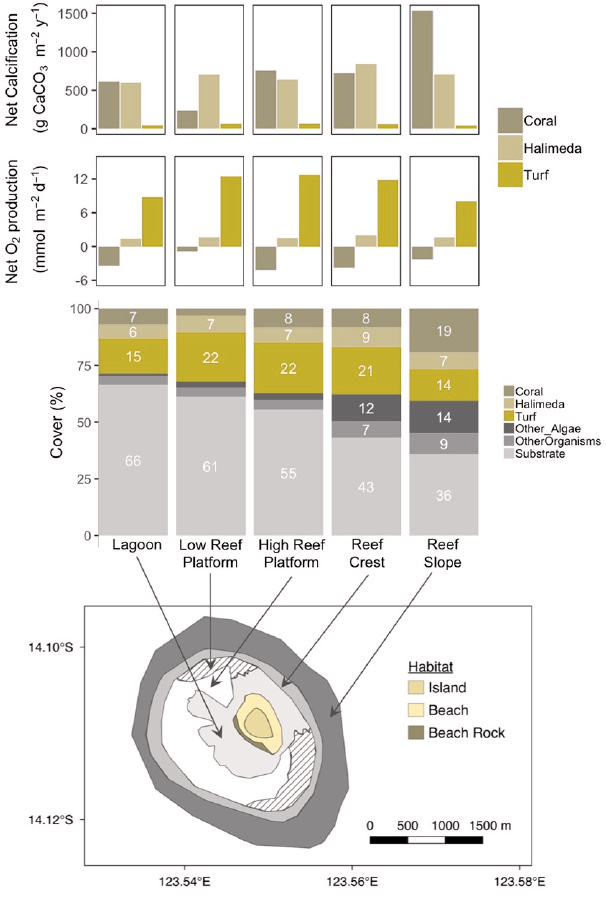
Figure 8. Map of the reef around Browse Island showing the major habitat types (bottom panel). Reef surface percent cover of coral, Halimeda , turf and other categories in each habitat (middle panel) based on drop-camera image analysis data from Olsen et al. (2017). Net calcification and net oxygen production by coral, Halimeda and turf per square metre of reef (top two panels) scaled up by multiply- ing rates obtained from incubations of each taxon by the percent cover in each